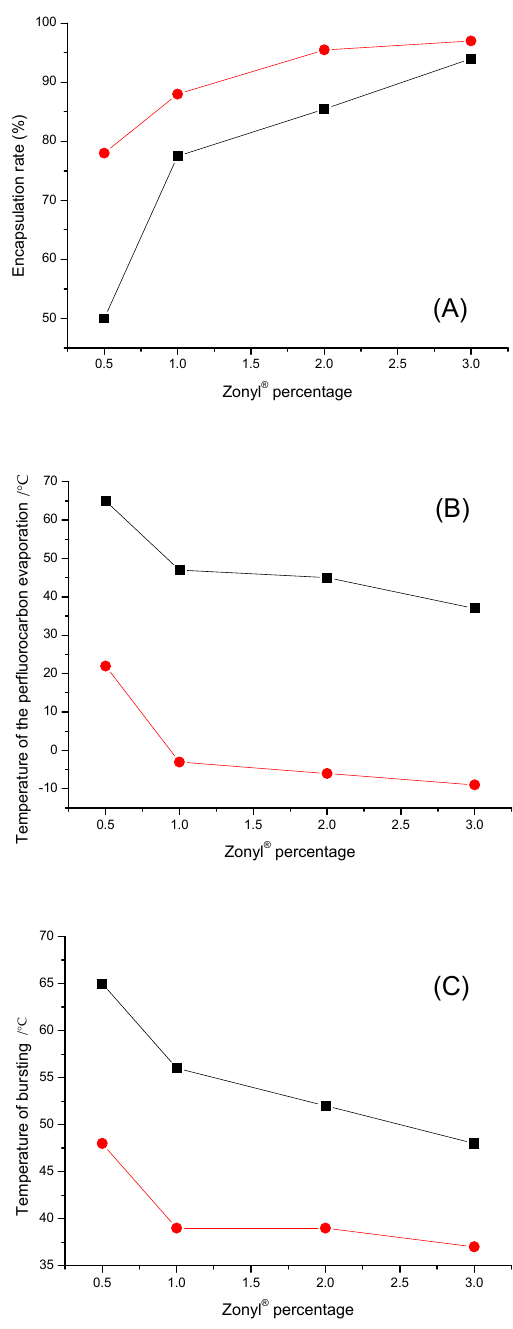
Figure 5. Evolution of encapsulation rate ( A ), perfluorocarbon temperature of evaporation ( B ), and temperature of bursting ( C ) as a function of Zonyl ® concentration for perfluorohexane ( (cid:4) ) and perfluoropentane ( ● ) based emulsions.